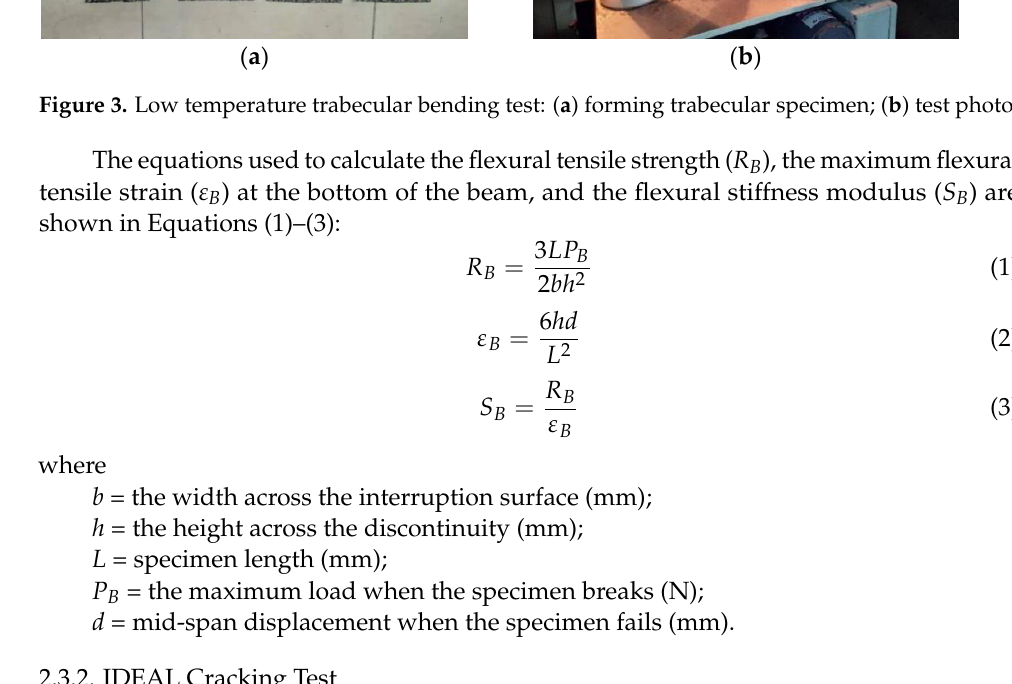
( b ) Figure 5. IDEAL cracking test: ( a ) forming trabecular specimen; ( b ) test photo. 75 index